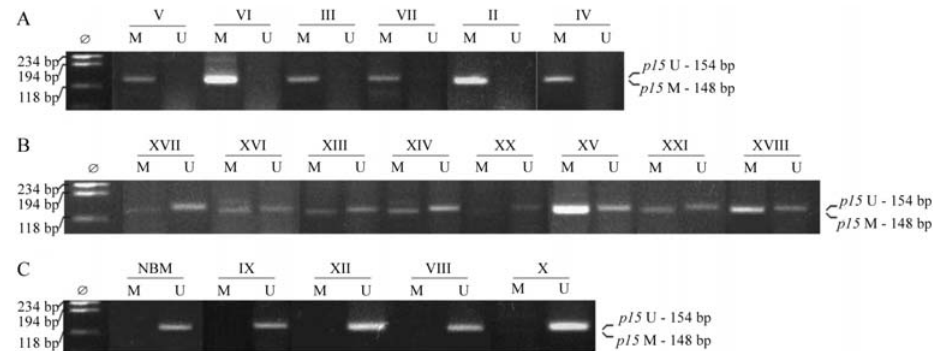
Figure 1 - MSP of CDKN2B . Primer sets used for amplification are designated as methylated (M) or unmethylated (U). The leukemia samples are repre- sented in Roman numbers. NBM = normal bone marrow. (A) Samples amplified with methylated primer set. (B) Samples amplified with methylated and unmethylated primer sets. (C) Samples amplified with unmethylated primer